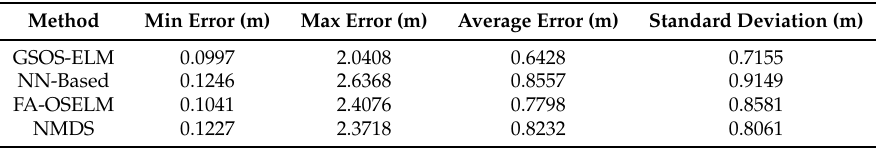
Table 6. Comparison Result under Dynamic Simulation